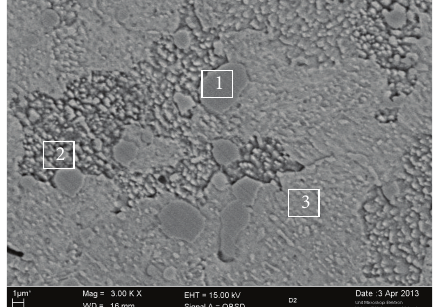
Figure 2: Schematic of DPRM experiment.